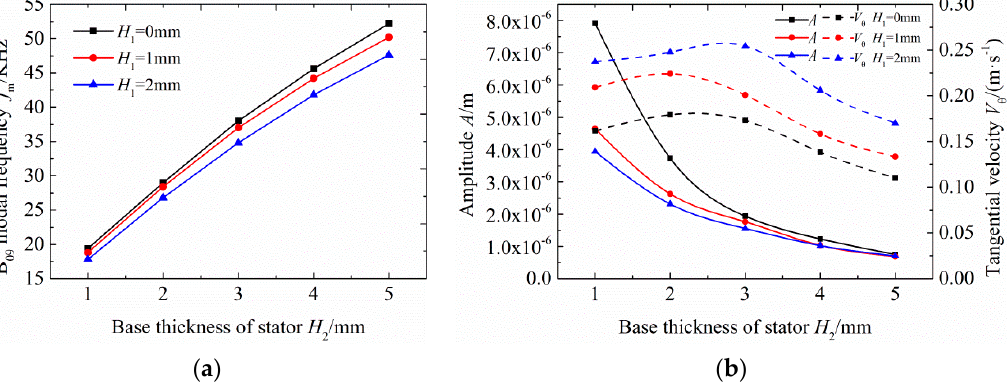
Figure 8. ( a ) Modal frequency affected by the base thickness and tooth height of the stator and ( b ) amplitude affected by the base thickness and tooth height of the stator.